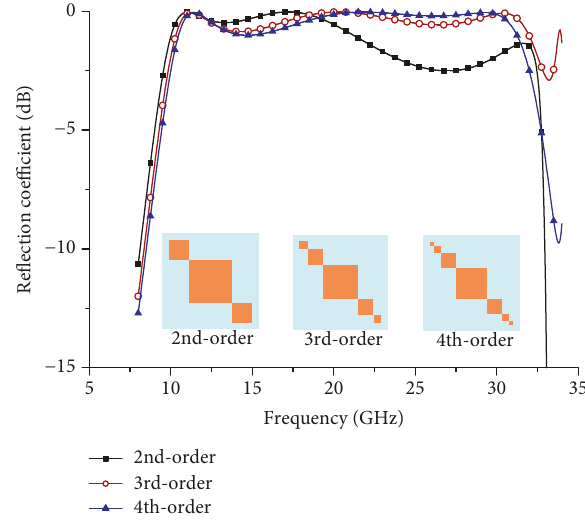
Figure 2: Discussion on the iteration of the